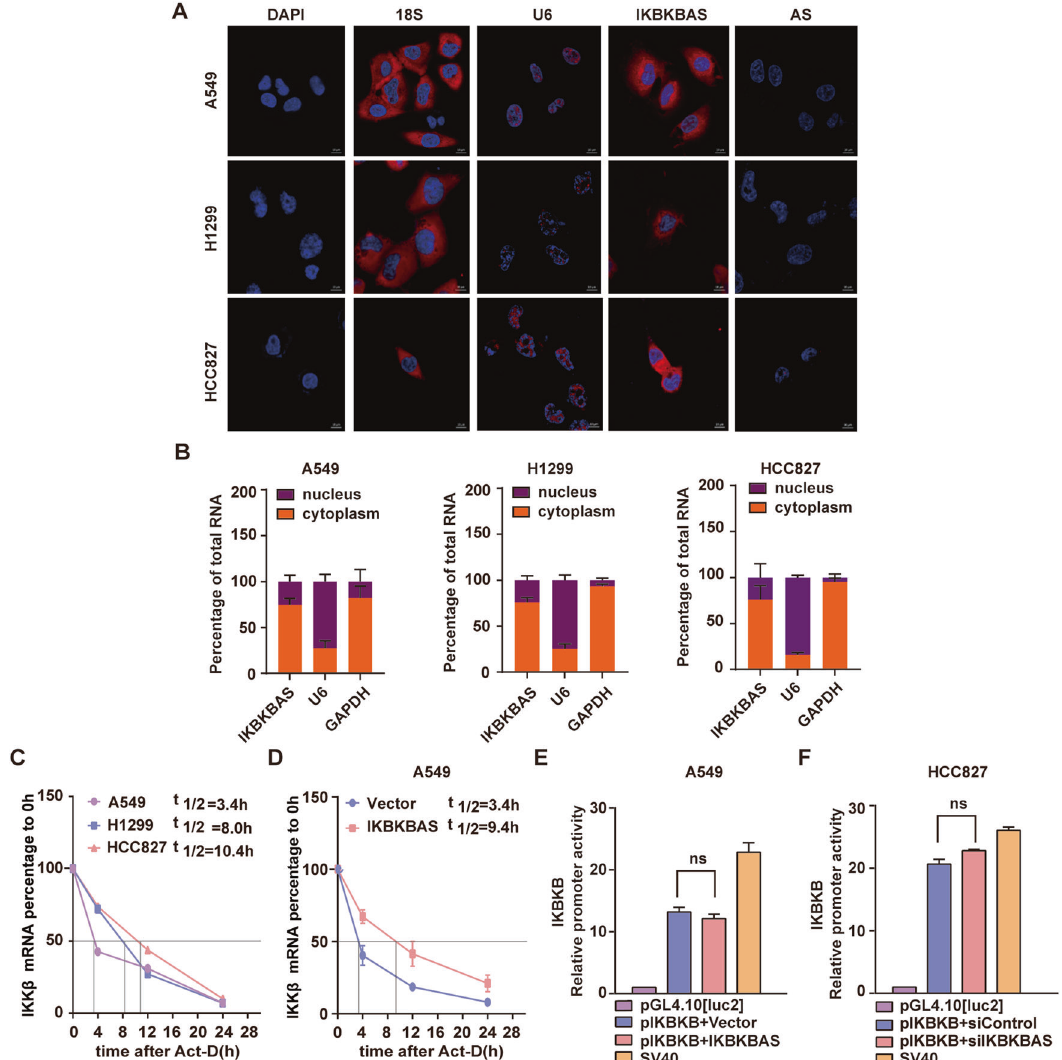
Fig. 4 Cytoplasmic IKBKBAS upregulates IKK β at post-transcriptional level. A Confocal FISH images showing cytoplasmic localization of IKBKBAS in A549, H1299, and HCC827 cells, respectively. The nuclei were stained with DAPI, U6 snRNA, and 18S rRNA was used as a nuclei and cytoplasmic marker, respectively. IKBKBAS-AS were used as negative control. Scale bar: 10 μ m. B Cell nuclear/cytoplasmic fractionation and qRT-PCR assay showing the cellular distribution of IKBKBAS in A549, H1299, and HCC827 cells, respectively. U6 and GAPDH were used as separation quality standards and endogenous controls. C The kinetics of IKK β mRNA in A549, H1299, and HCC827 cells treated with Act-D were assayed by qRT-PCR, respectively. D The kinetics of IKK β mRNA in A549 cells with ectopic IKBKBAS expression and Act-D treatment were assayed by qRT-PCR. E Luciferase reporter assay showing the effect of IKBKBAS on promoter activity of IKBKB gene in A549 cells with ectopic expression of IKBKBAS. F Luciferase reporter assay showing the effect of IKBKBAS on promoter activity of IKBKB gene in HCC827 cells with knockdown of IKBKBAS